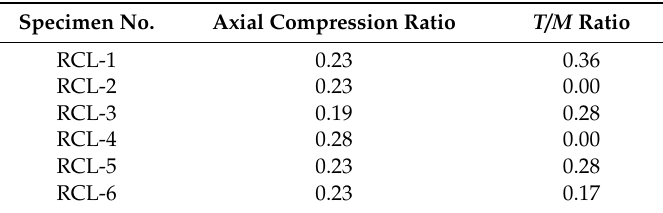
Figure 3. Test setup. Table 1. Load parameters of